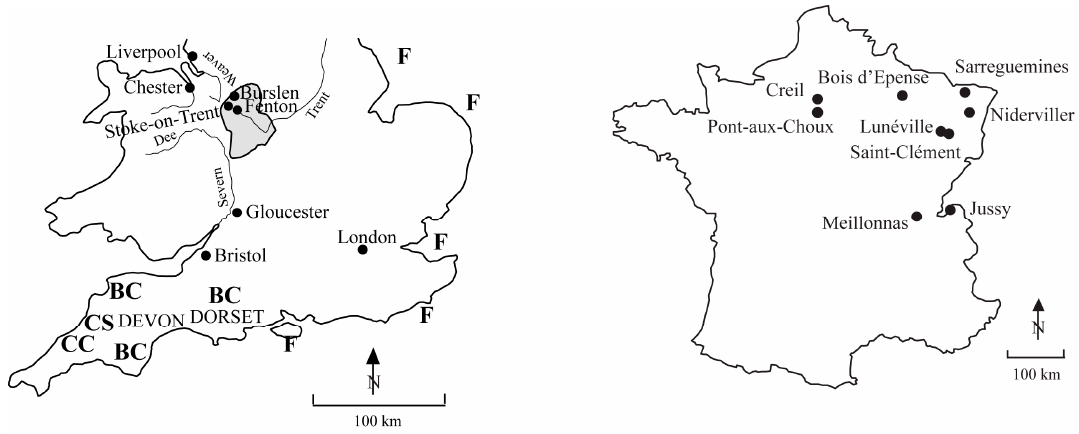
Figure 1. Maps of England and France with manufacturing sites mentioned. The former shows the sources of ceramic raw materials used in 18th century Staffordshire (grey area) potteries. BC = ball clay, CC = china clay, CS = Cornish stone, F = flint.